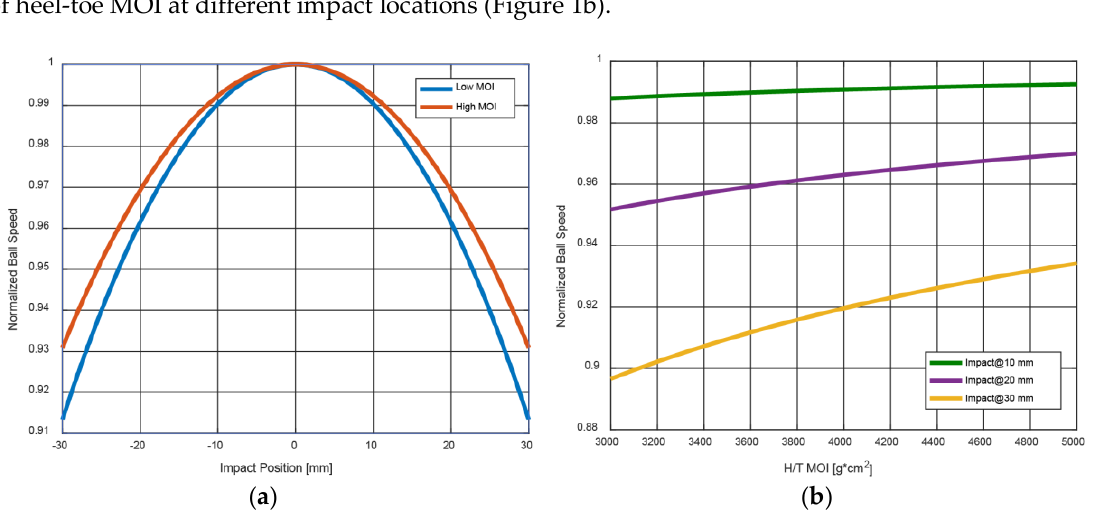
Figure 1. Rigid body putter ball speed simulation ( a ) as a function of impact position for two putters and ( b ) as a function of heel-toe moment of inertia for 3 impact